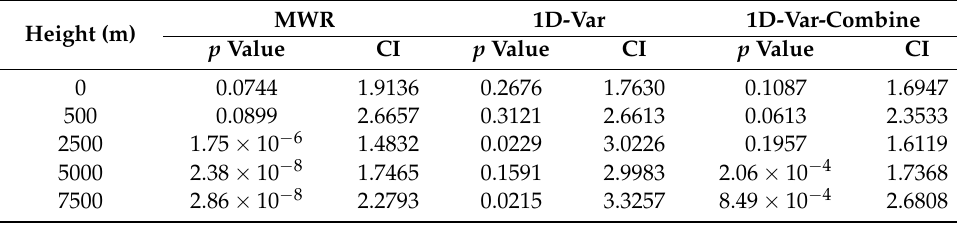
Table 1. Statistical significance in temperature profiles in the clear-sky